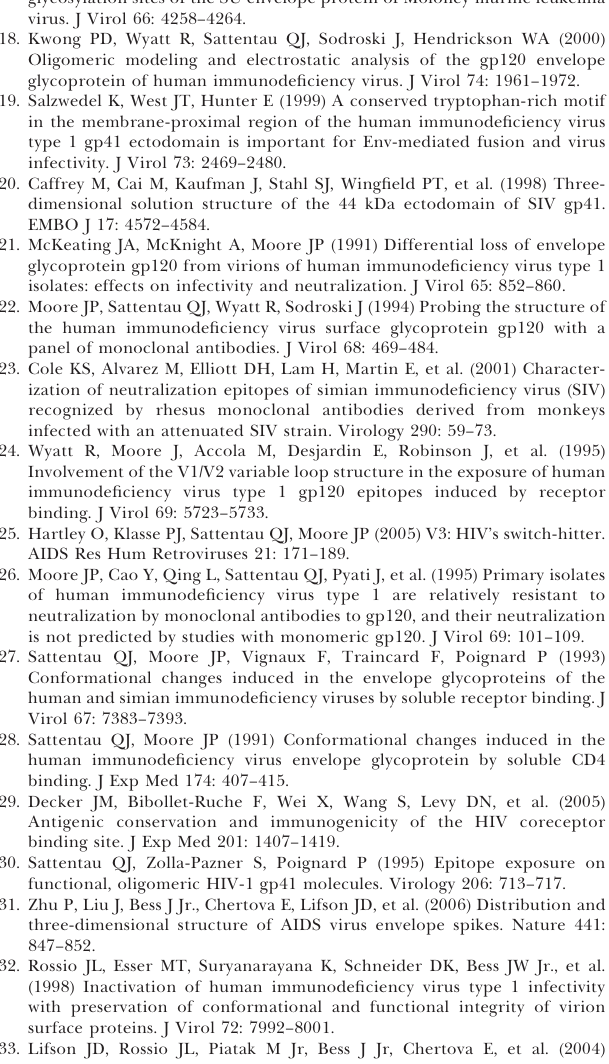
Figure S2. Three-Fold Symmetry of the Env Complex Slices on the xy plane through the membrane distal region of the Env complex (corresponding to the gp120 trimer). Panel (A) shows the density after one iteration of alignment of the in plane rotation angle phi. Panels (B–F) show the density after two to six iterations of alignment, without imposing any symmetry. The 3-fold character of the Env complex is clear from the output of these early alignment